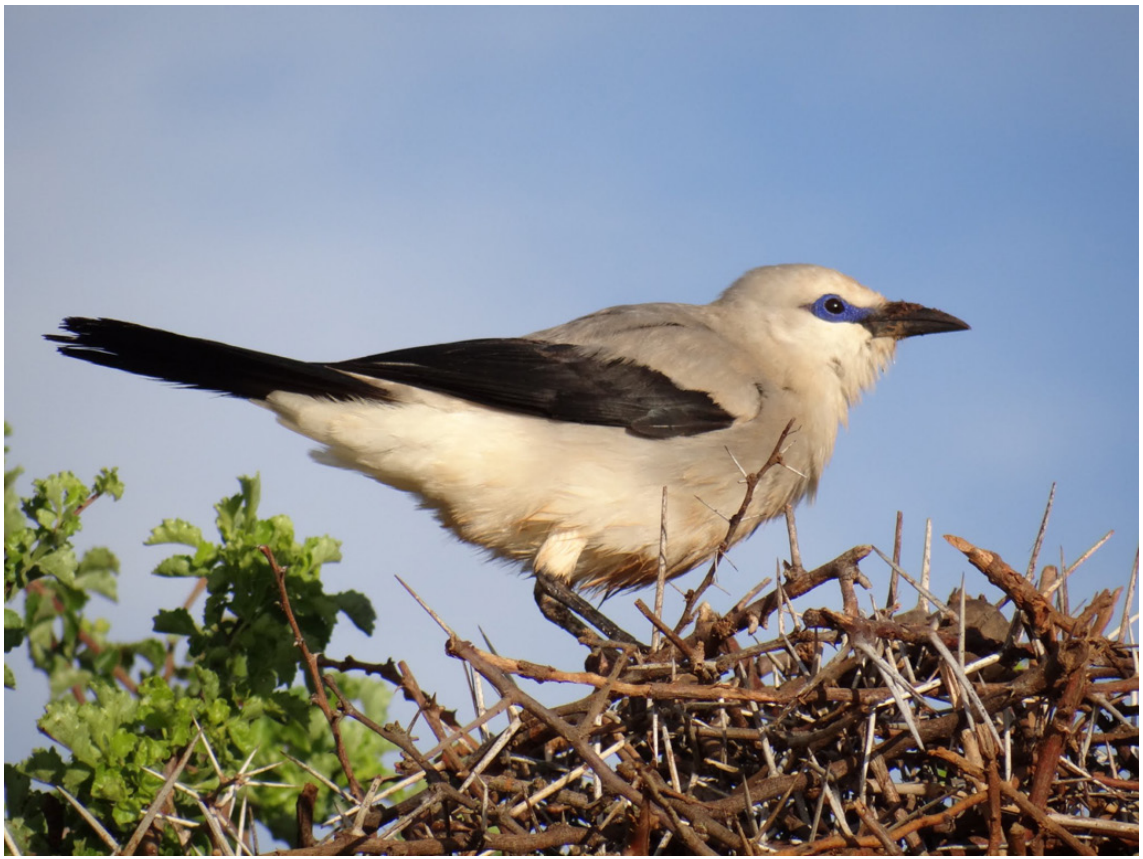
Fig. 5. The Ethiopian Bush-crow Zavattariornis stresemanni Moltoni, 1938 is restricted to the Borana zone in SE Oromia, with a total range of just 6000 km² (Photo: Kai